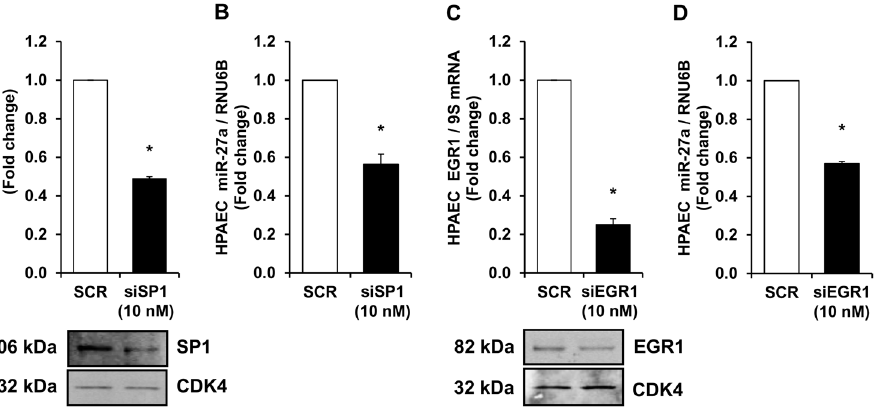
Figure 7. Knockdown of transcription factors, SP1 and EGR1, attenuates miR-27a expression. HPAEC were treated with 10 nM scrambled (SCR) or siRNA duplexes to SP1 or EGR1 for 72 hours. HPAEC mRNA or proteins were then isolated. qRT-PCR was performed demonstrating decreases in SP1 ( A ) or EGR1 ( C ) mRNA levels following treatment with siRNA. Each bar represents the mean 6 SE SP1 or EGR1 relative to 9S in the same sample expressed as fold-change vs. cells treated with scrambled siRNA (SCR). n=3, *p , 0.05 vs. SCR. Western blotting was employed to detect SP1 ( A ) or EGR1 ( C ) protein levels. Representative blots depicting SP1 or EGR1 protein depletion in siRNA-treated HPAEC is shown. n=3, *p , 0.05 vs. SCR. HPAECs were treated with SCR or siRNA duplexes to SP1 or EGR1, and miRNA was isolated and subjected to qRT-PCR analysis along with RNU6B. Each bar represents the mean 6 SE miR-27a relative to RNU6B expressed as fold change vs. SCR. n=3, *p , 0.05 vs. SCR. miR-27a levels were downregulated following SP1 ( B ) or EGR1 ( D ) depletion in